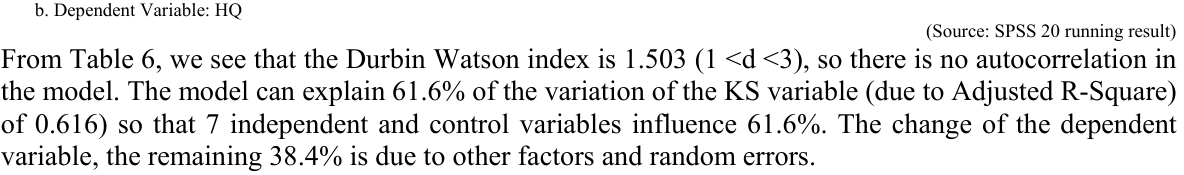
Verification of relevance Model Sum of Squares Df Mean Square F Sig. 1 Regression 8.720 7 1.246 23.433 .000 b Residual 4.838 91 .053 Total 13.558